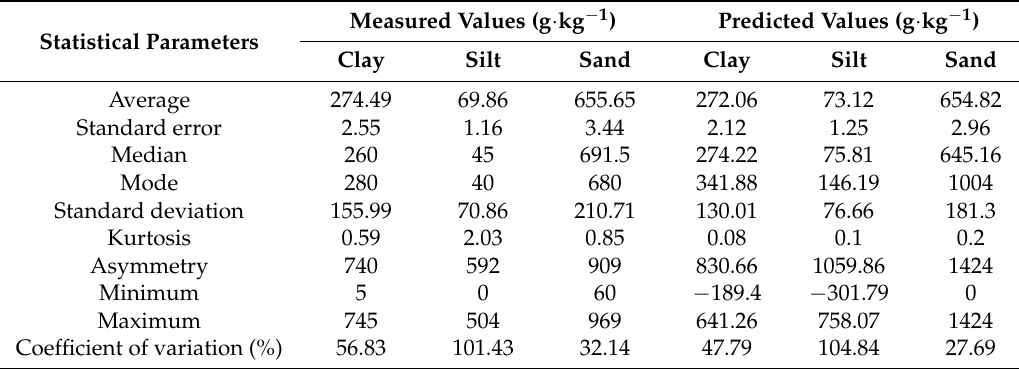
Table 1. Descriptive statistical analysis for clay, silt and sand measured and predicted by elaborated quantification of these soil attributes